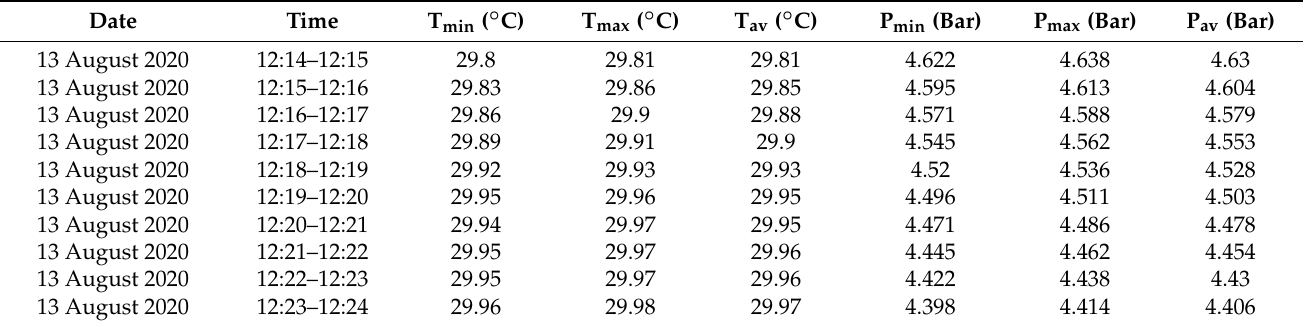
Table 2. Measured gas parameters (source: